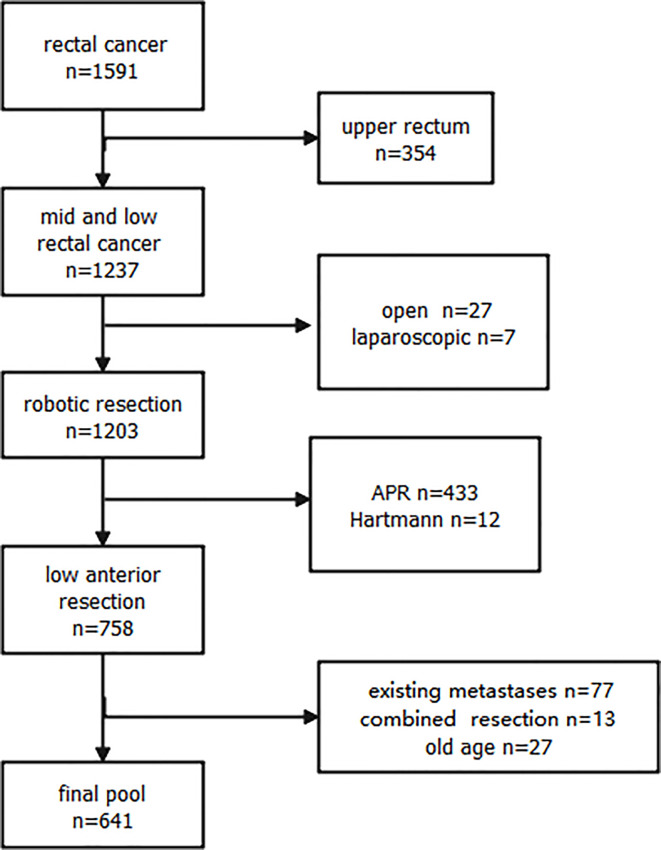
Flow Chart of Enrollment of Mid and Low Robotic Cancer.